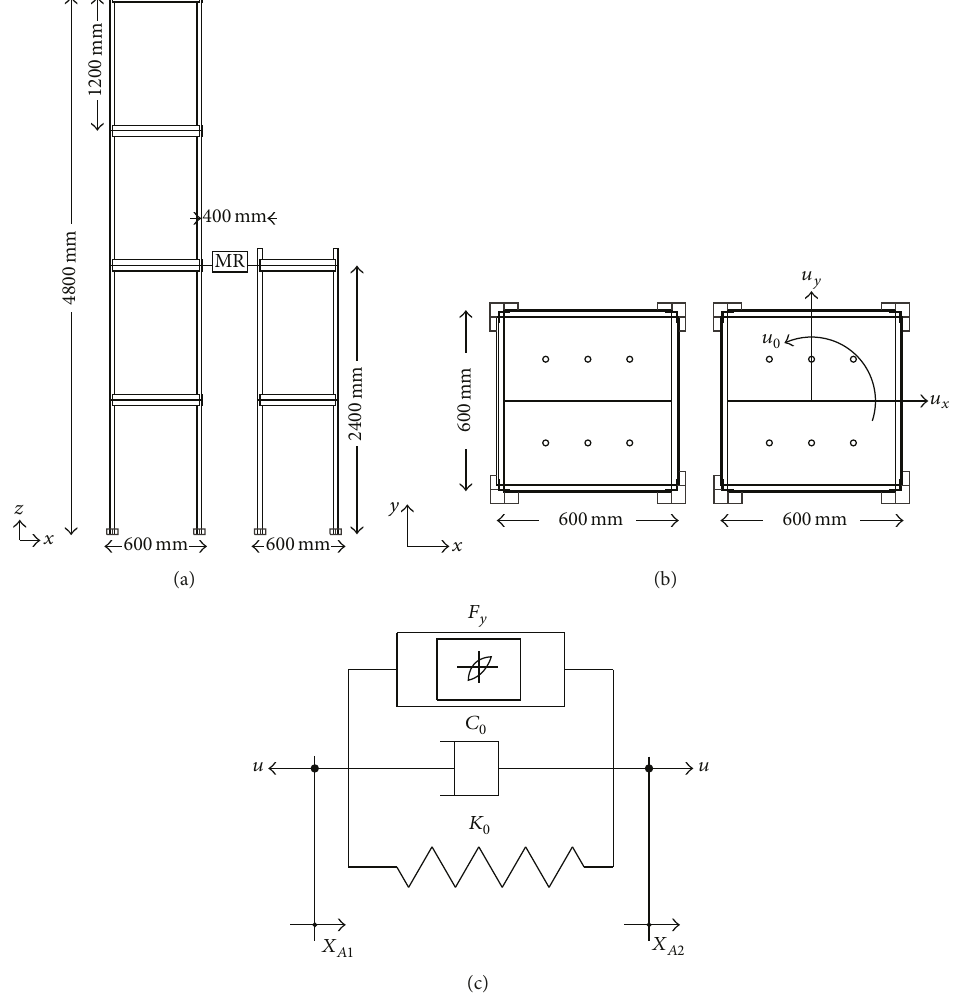
Figure 2: Dimensions of the adjacent structures and MR damper numerical model: (a) elevations; (b) plan, with model’s degrees of freedom; (c) device numerical